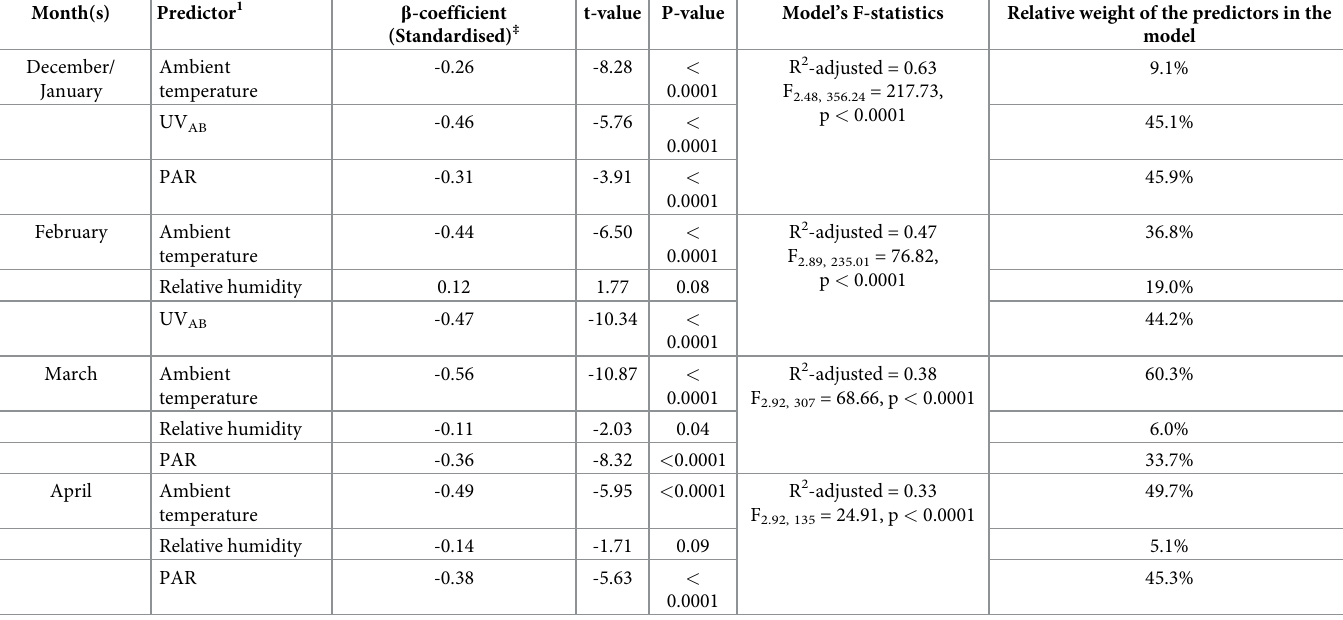
Table 5. Multiple ridge regression analyses (ridge parameter, k = 0.02) on the number of hens in the ‘sun’ across the day in QLD for different observation months. Only variables that significantly contributed to the most parsimonious model are